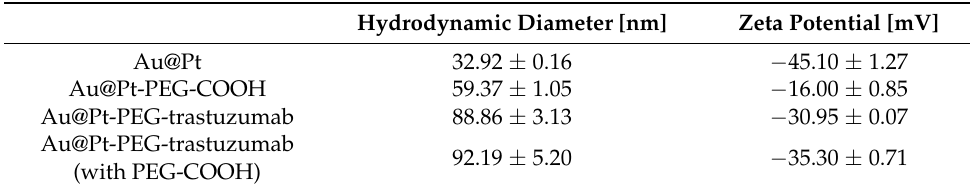
Figure 4. Schematic diagram of the synthesis of Au@Pt-PEG-COOH conjugate. Table 2. Hydrodynamic size and zeta potential of synthesized